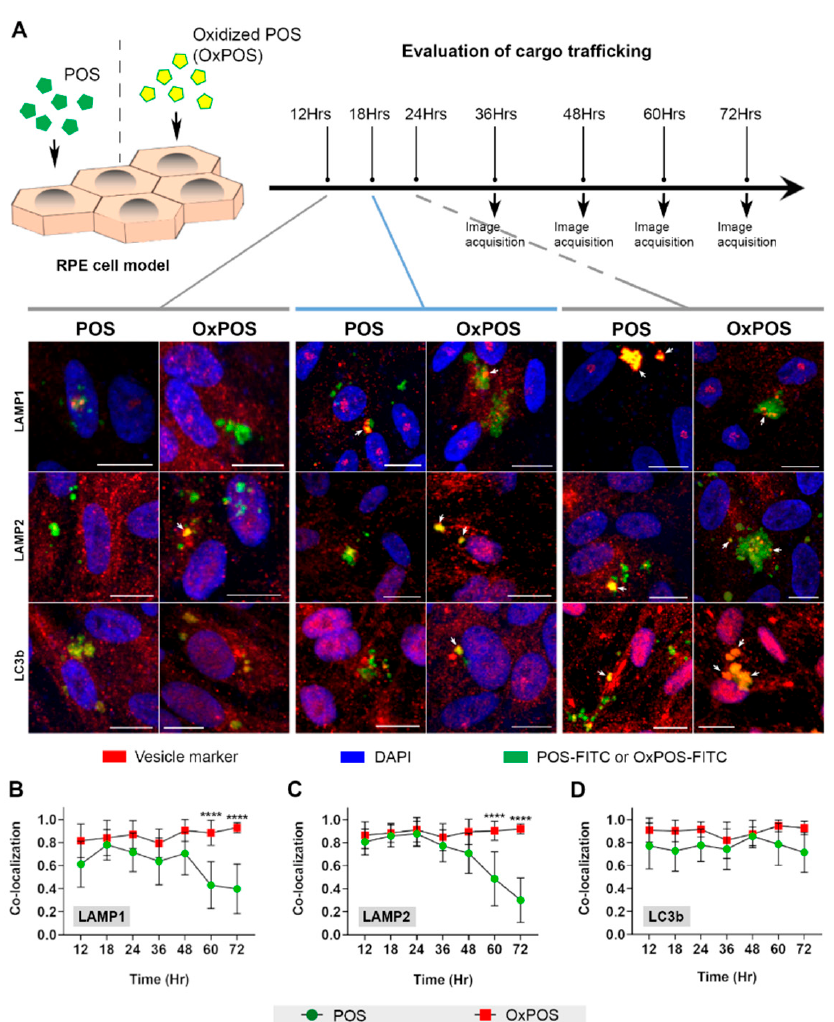
Figure 1. An initial screen evaluating the intracellular cargo trafficking in retinal pigment epithelial (RPE) cells. ( A ) A schematic diagram of the experimental plan, where cultured ARPE-19 cells were fed with either photoreceptor outer segments (POS) or oxidized POS (OxPOS). Tra ffi cking was assessed by confocal immunofluorescence microscopy from 12 h onwards, when cargos are expected to reach late compartments. Following incubation with either POS or OxPOS, a screen spanning the full range of time points in the study was performed. Internalized cargos (green) were observed to co-localize with vesicles in the autophagy-lysosomal pathways (red) and appeared yellow (arrows). Compared to POS, OxPOS appeared to form more noticeable intracellular puncta (indicated by arrows showing prominent / large OxPOS aggregates). Representative images illustrate the contrasting fates of POS vs. OxPOS, which were quantified using an unbiased, automated algorithm described by Costes et al. [36] and shown for ( B ) LAMP1, ( C ) LAMP2 and ( D ) LC3b. At 12 h, POS and OxPOS were co-localized